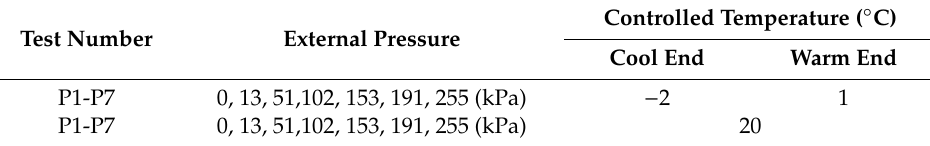
Table 2. Experimental conditions.